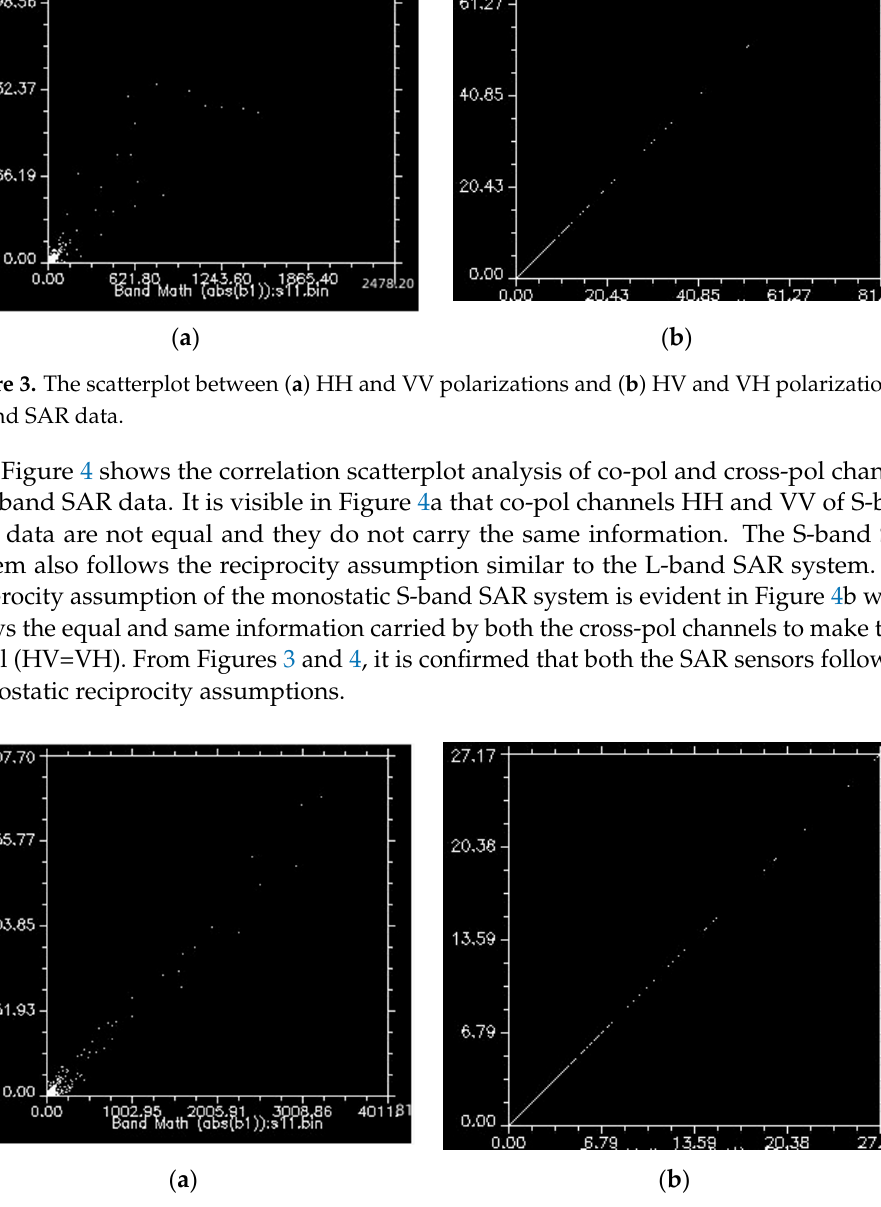
Figure 4. The scatterplot between ( a ) HH and VV polarizations and ( b ) HV and VH polarizations of S-band SAR data.